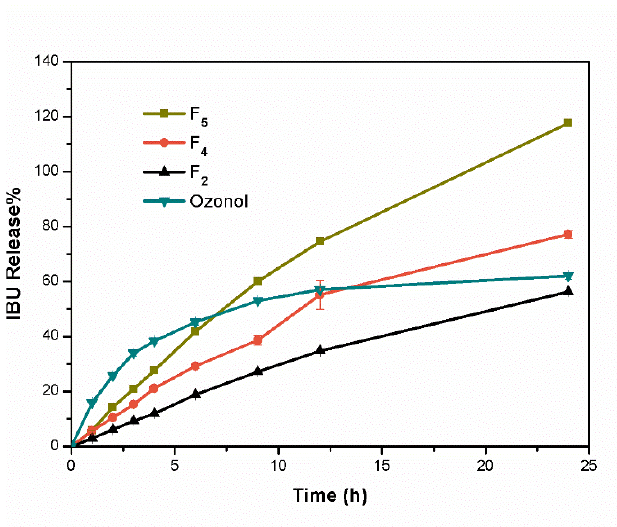
FIGURE 3 - In vitro release profiles of patch formulations with different adhesives. The results are expressed as mean ± SEM